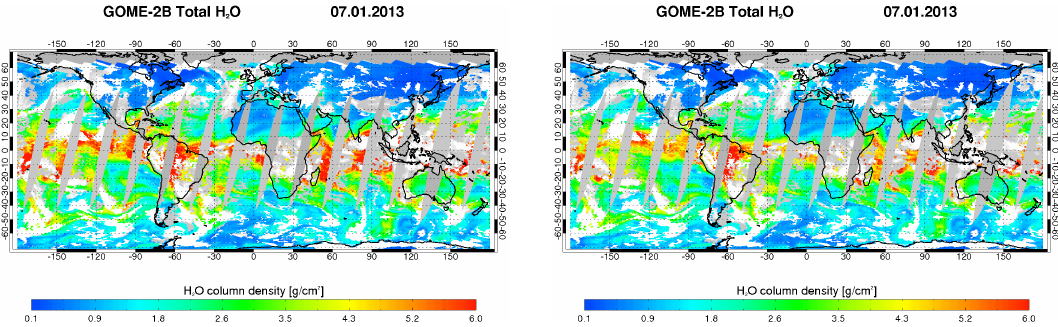
Figure 2. H 2 O total columns derived from GOME-2B measurements for the 7 January 2013 without the SAD correction (on the left) and using the SAD correction (on the right). Only cloud-screened data corresponding to solar zenith angles smaller than 87 ◦ are shown.